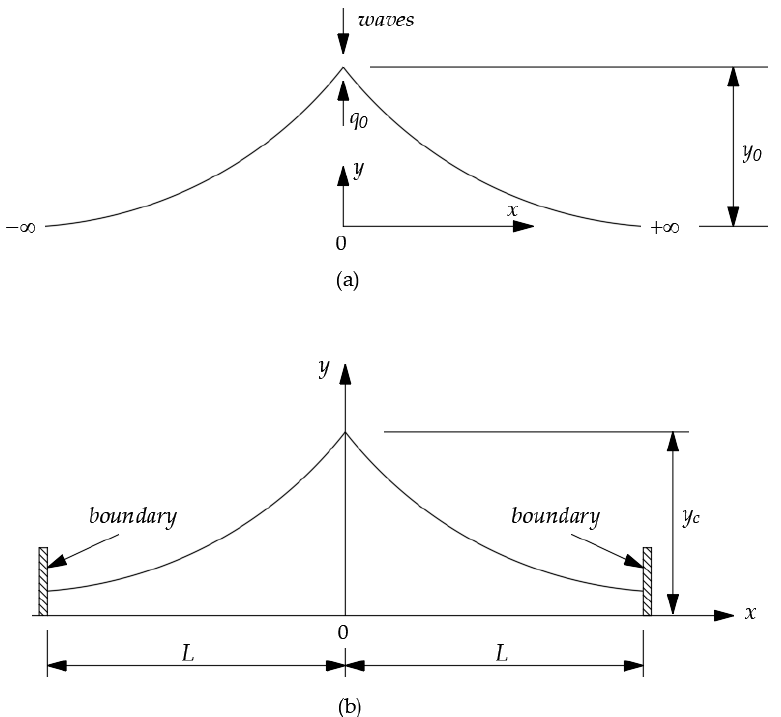
Figure 2. Schematic diagram for delta-shoreline formation owing to sediment supply from the river as a point source; ( a ) infinite-length beach, ( b ) finite-length beach.